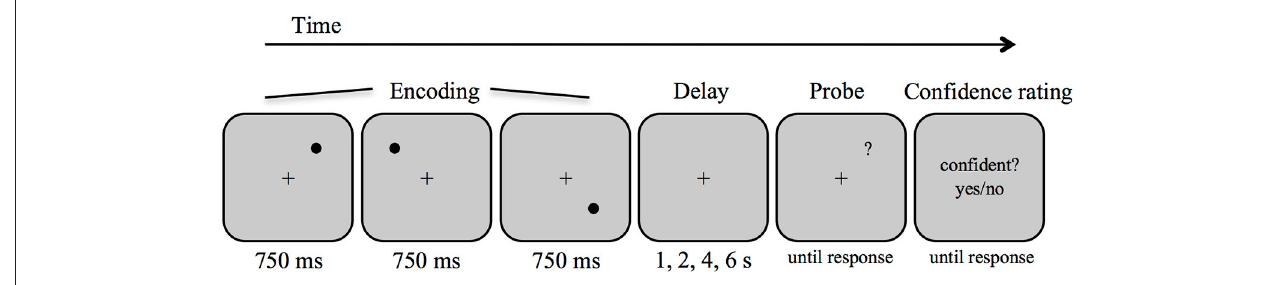
FIGURE 1 | Schematic diagram of the procedure and stimuli in the spatial delayed response task.